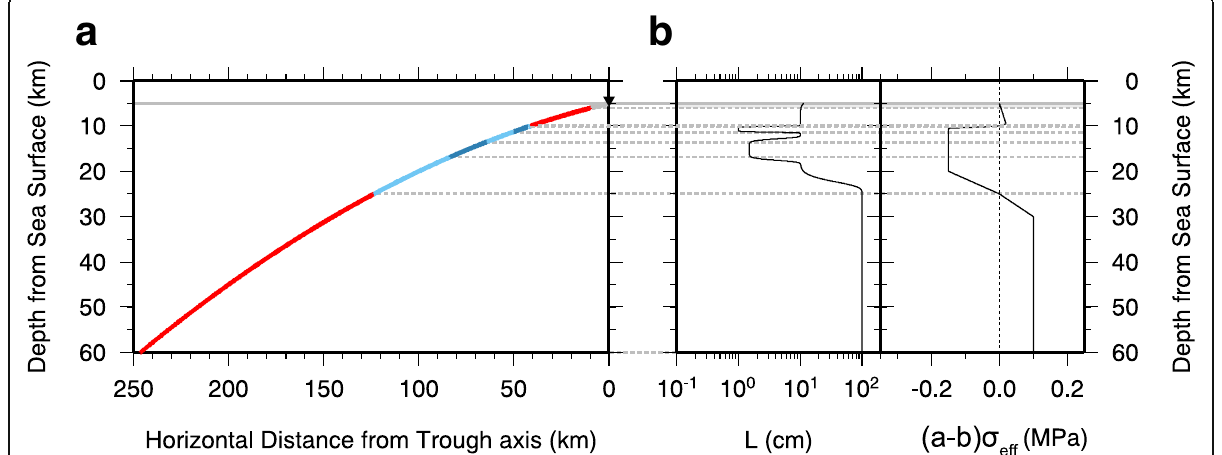
Fig. 6 Model setting of 2D earthquake cycle simulation. a Configuration of model plate interface and the schematic illustration of stable or unstable regions. Colors on the model plate interface reflect the assumed distribution of frictional parameters, ( a – b ) σ eff : red and blue colors denote stable and unstable regions, respectively. The shallow gray segment denotes the steady sliding zone. b Depth profiles of frictional parameters used to simulate an earthquake cycle